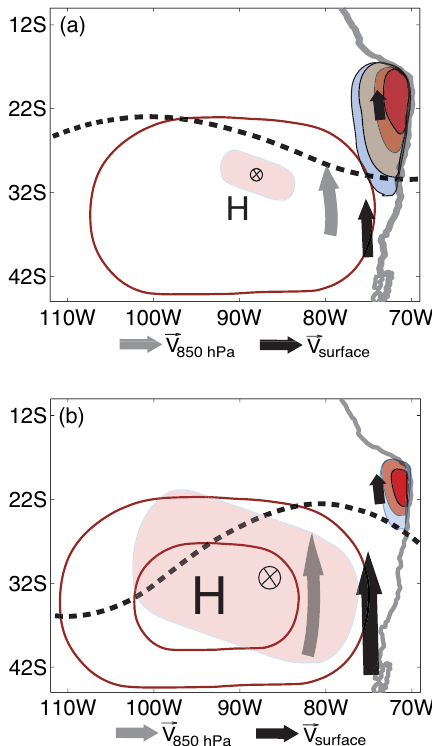
Fig. 13. Schematic of a) MAX N d , and (b) MIN N d large-scale meteorology. The 500hPa geopotential height is indicated by the dashed line, the sea-level pressure by red contours, subsidence by the shaded area, 850 hPa and surface winds by grey and black ar- rows respectively. The color shading over Arica Bight indicates the region with large N d